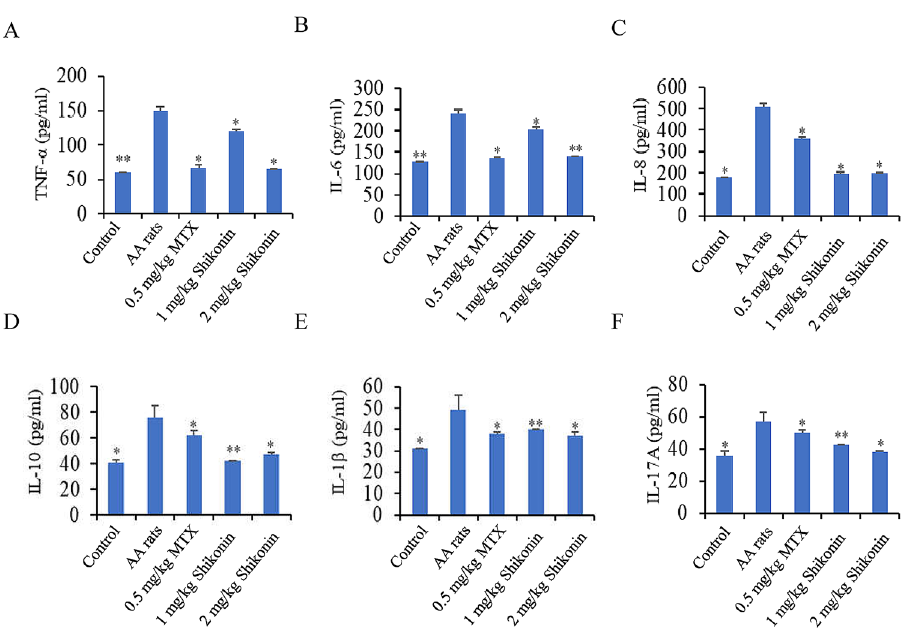
Figure 7. Effects of shikonin on TNF-α, IL-6, IL-8, IL-10, IL-1β, IL-17A levels and release in AA rat serum. ( A ) Serum TNF-α was detected by ELISA. ( B ) Serum IL-6 was detected by ELISA. ( C ) Serum IL-8 was detected by ELISA. ( D ) Serum IL-10 was detected by ELISA. ( E ) Serum IL-1β was detected by ELISA. ( F ) Serum IL-17A was detected by ELISA. * p < 0.05, ** p < 0.01, compared to the AA Rats group. Data are representative of at least three independent